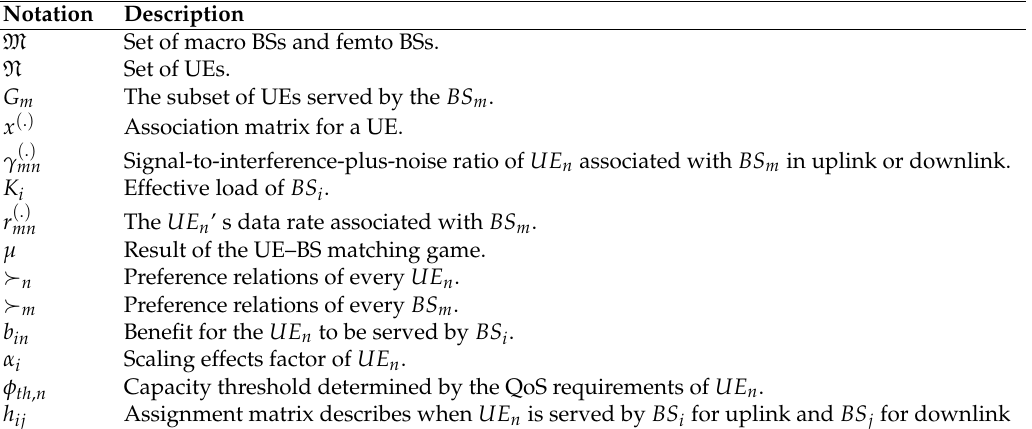
Table 2. Mathematical